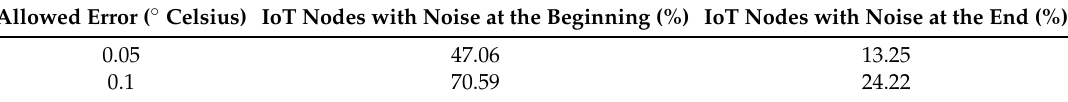
Table 4. Table showing the possible errors and % of noise both during and after applying the